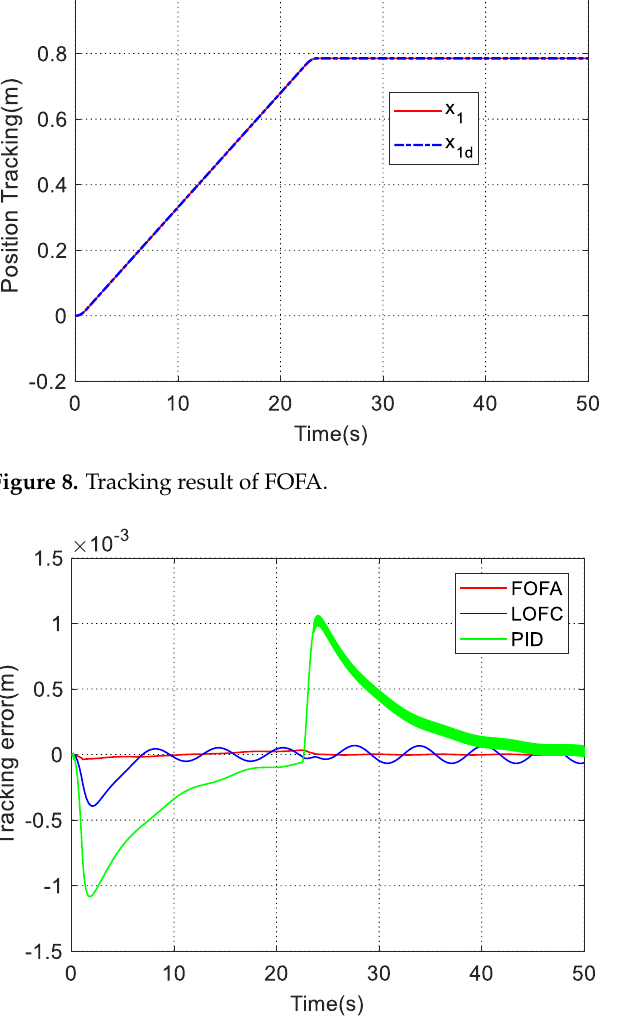
Figure 9. Comparison of position tracking error.